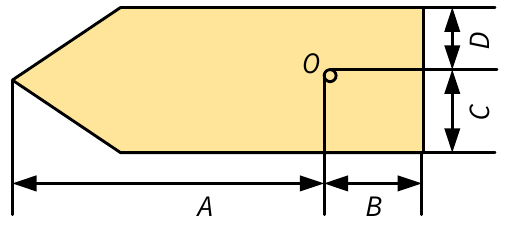
Figure 3. The reference point O and the overall dimensions of a ship.